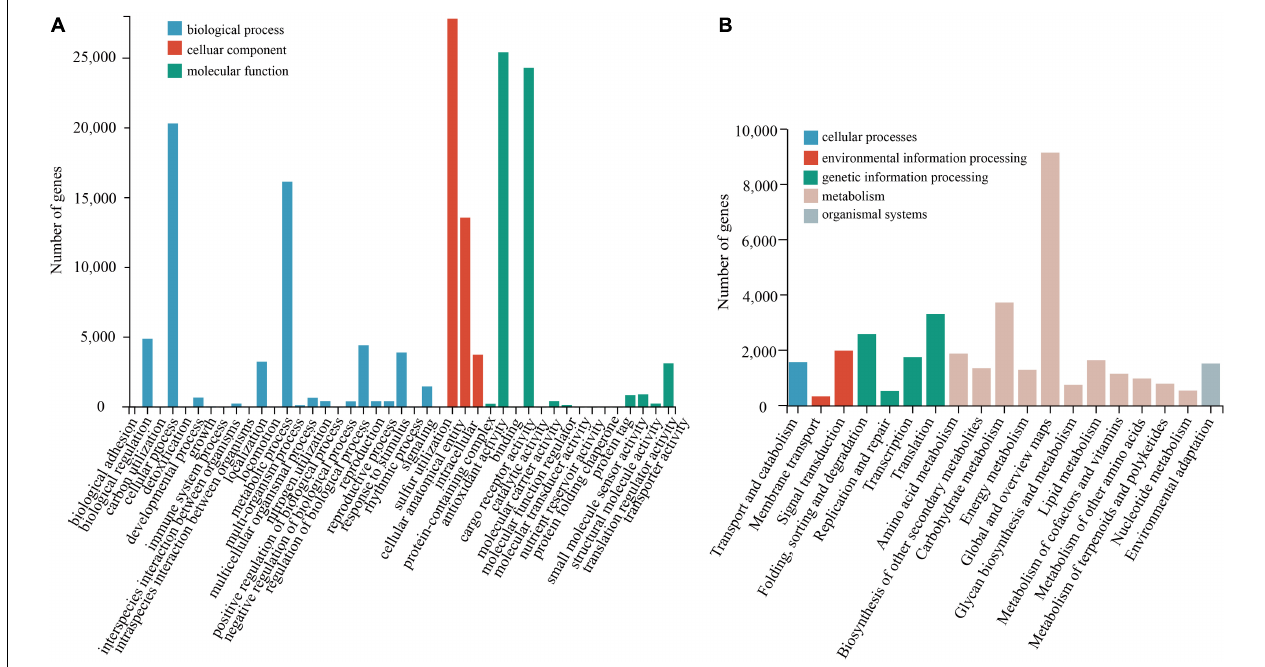
FIGURE 2 | Functional and pathway enrichment of unigenes. (A) GO enrichment with three primary classifications of biological process, cellular component, and molecular function. (B) Functional classification and pathway assembled unigenes by KEGG.